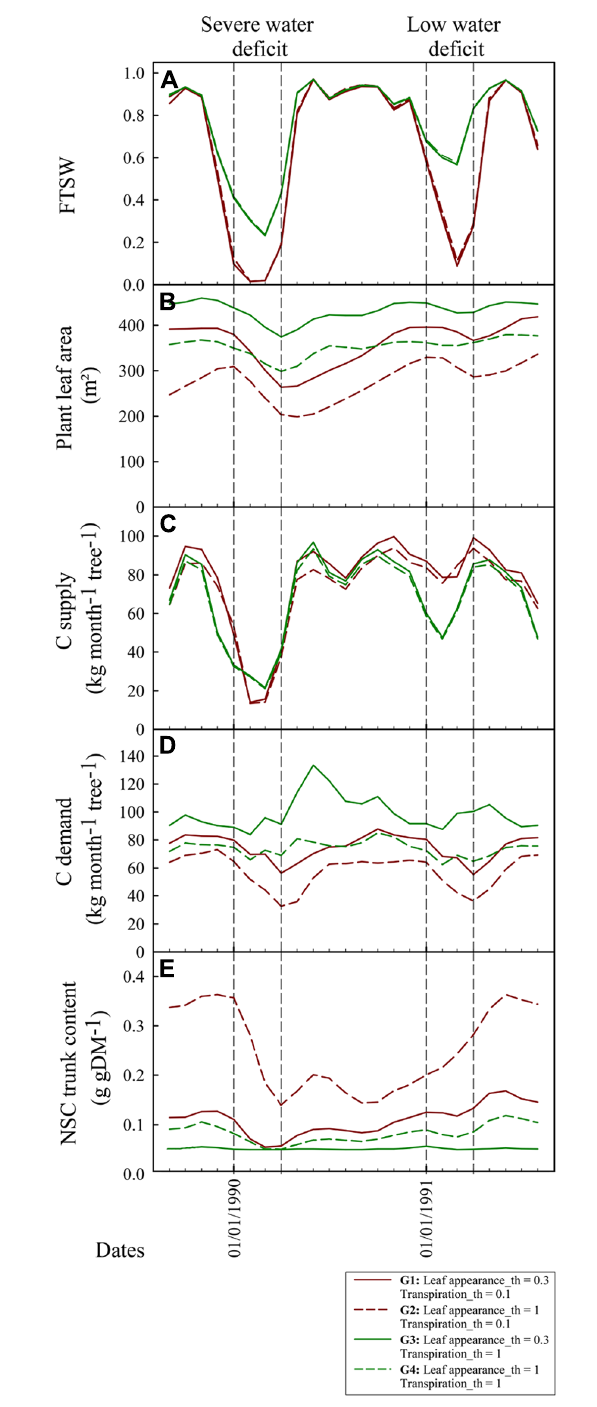
FIGURE 7 | Dynamical simulation with X-Palm of FTSW (A), total plant leaf area [m 2 , (B)], monthly carbohydrate supply per tree [kg CH 2 O tree -1 month -1 , (C)], monthly carbohydrate demand per tree [kg CH 2 O tree -1 month -1 , (D)], and non-structural carbohydrate content in the trunk [g gDM -1 , (E)] of oil palm for four genotypes contrasting for transpiration and leaf appearance rates sensitivity to drought (Leaf appearance_th andTranspiration_th). Vertical bars indicate the severe and low dry seasons presented in Figure 6